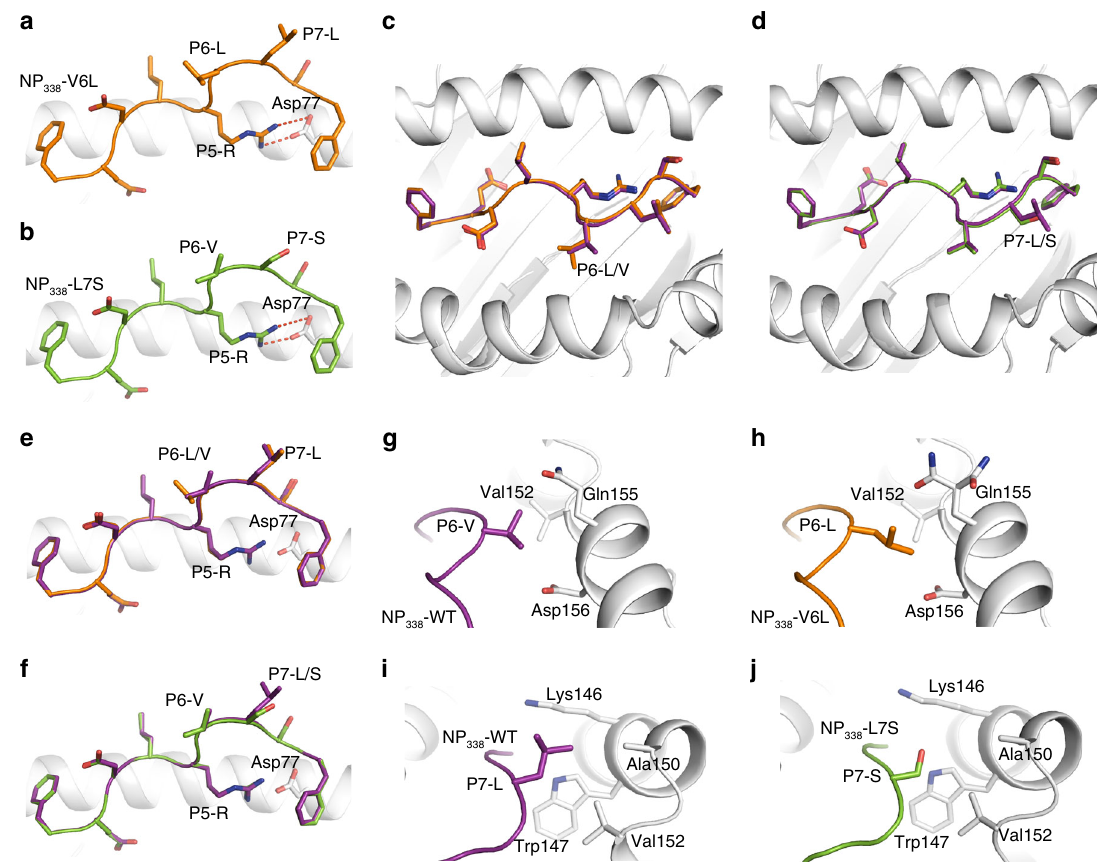
Fig. 3 Structures of HLA-B37 bound to NP 338 and its two variants. Structure of the HLA-B37 (white cartoon) presenting either a NP 338 -V6L (orange) or b NP 338 -L7S (green). c , d Top view or e , f side view of the structural overlay of HLA-B37 (white cartoon) presenting the NP 338 (purple) with either c , e NP 338 - V6L (orange) or d , e NP 338 -L7S (green). g – j Zoomed in view on the HLA-B37 interaction with residue at position 6 ( g , h ) and position 7 ( i , j ) of the NP 338 (purple), NP 338 -V6L (orange) and NP 338 -L7S (green) peptides. The red dashed lines represent salt bridges between